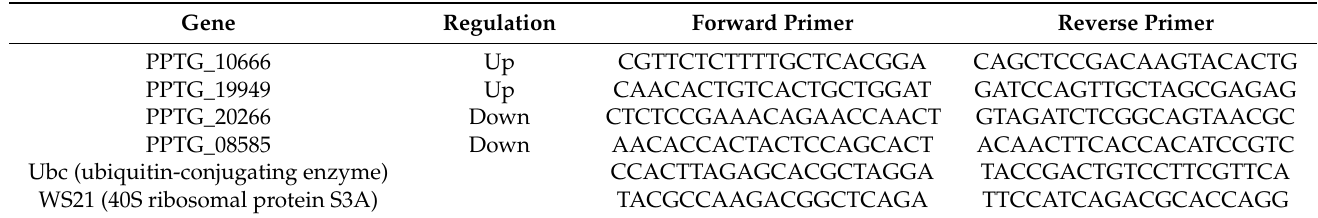
Table 1. Genes and corresponding primers used for qRT-PCR